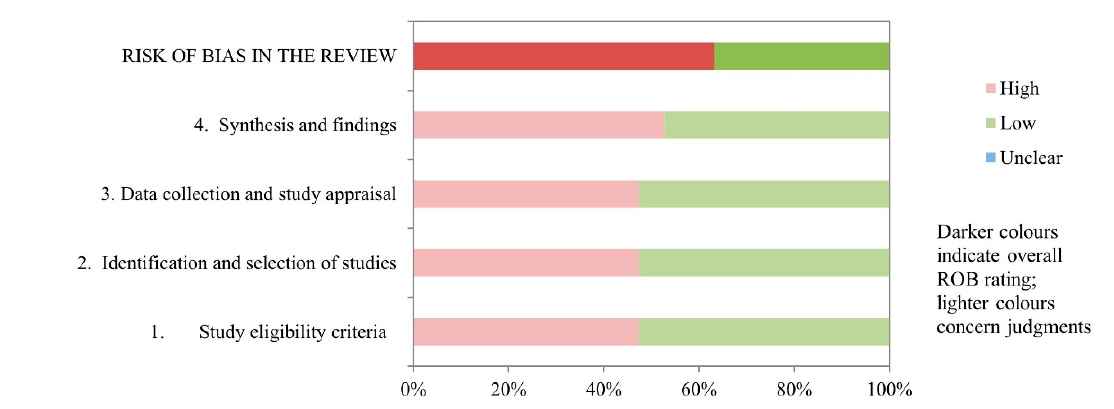
Figure 2. Graphical representation of the ROBIS results.